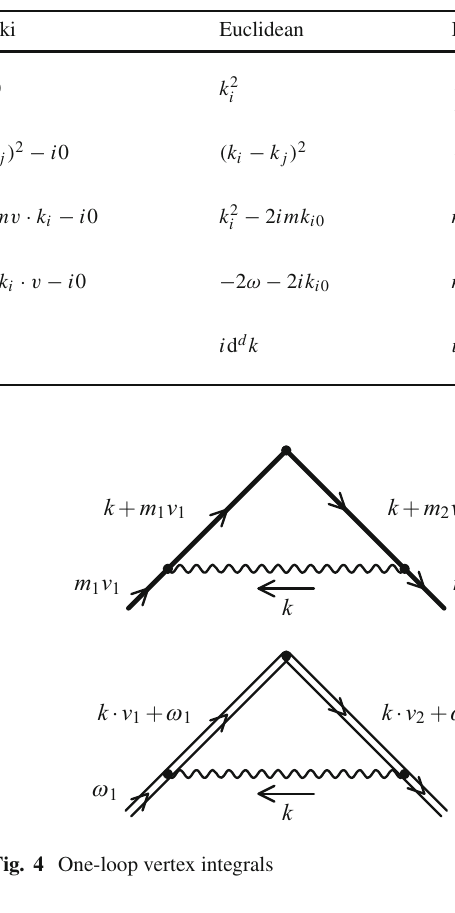
Fig. 4 One-loop vertex